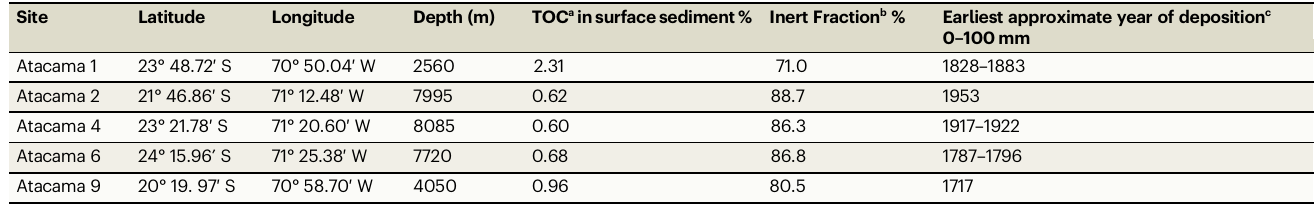
Table 1 | Sampled sites in the Atacama trench area, with coordinates, water depth and Total Organic Carbon (TOC) content (%) and Inert fraction (%) in surface sediment (0 − 10 mm)